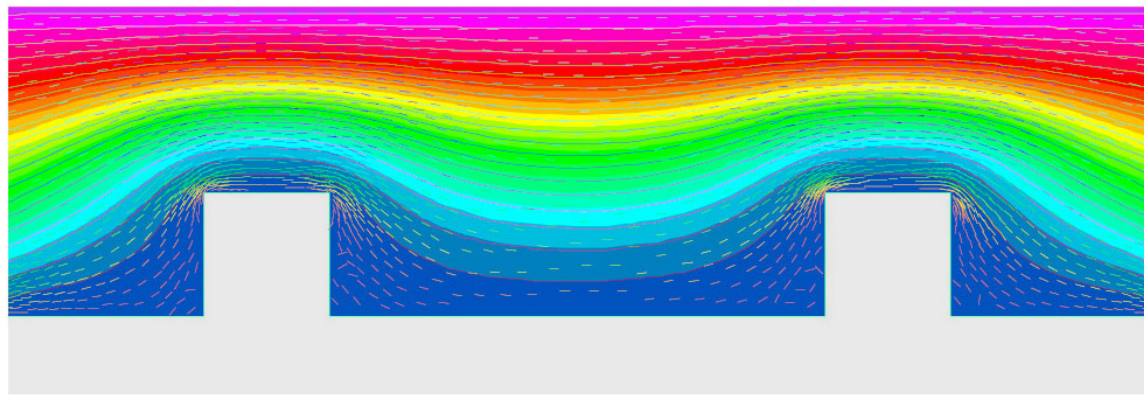
Figure 3. Streamlines for D < 0.3.